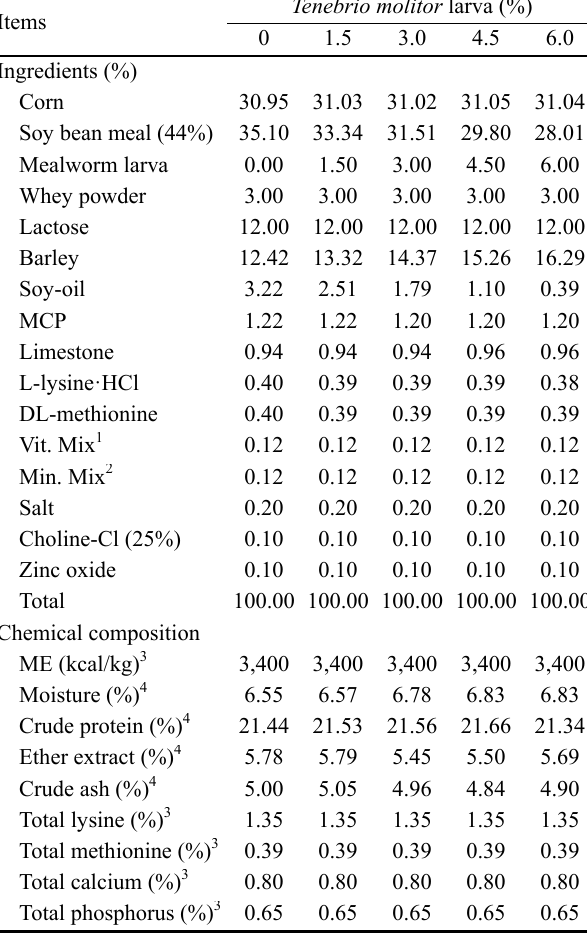
Table 2. The formula and chemical composition of experimental diets (phase I, d 0 to 14); as fed basis Tenebrio molitor larva Items